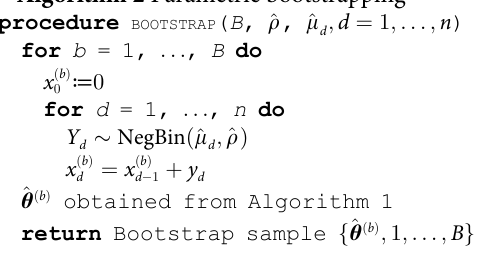
Algorithm 2 Parametric